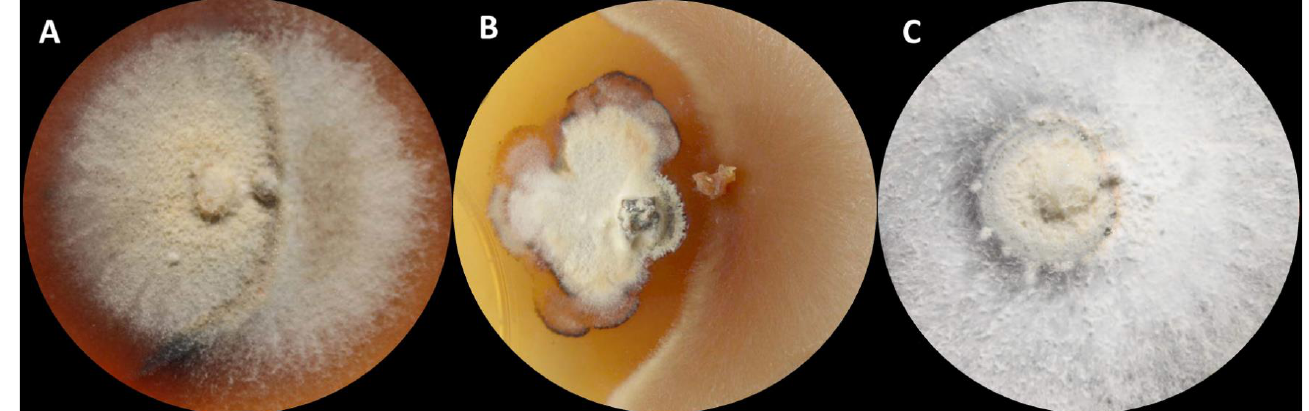
Figure 2. The outcome of dual culture screening assay between Hymenoscyphus fraxineus (on the left) and different tested fungi (on the right). ( A ) Both fungi meet and form a barrage zone – deadlock reaction; ( B ) The inhibition zone is formed between H. fraxineus and the tested fungus – antibiosis reaction; ( C ) The tested fungus shows the overgrowth of H. fraxineus – replacement reaction.